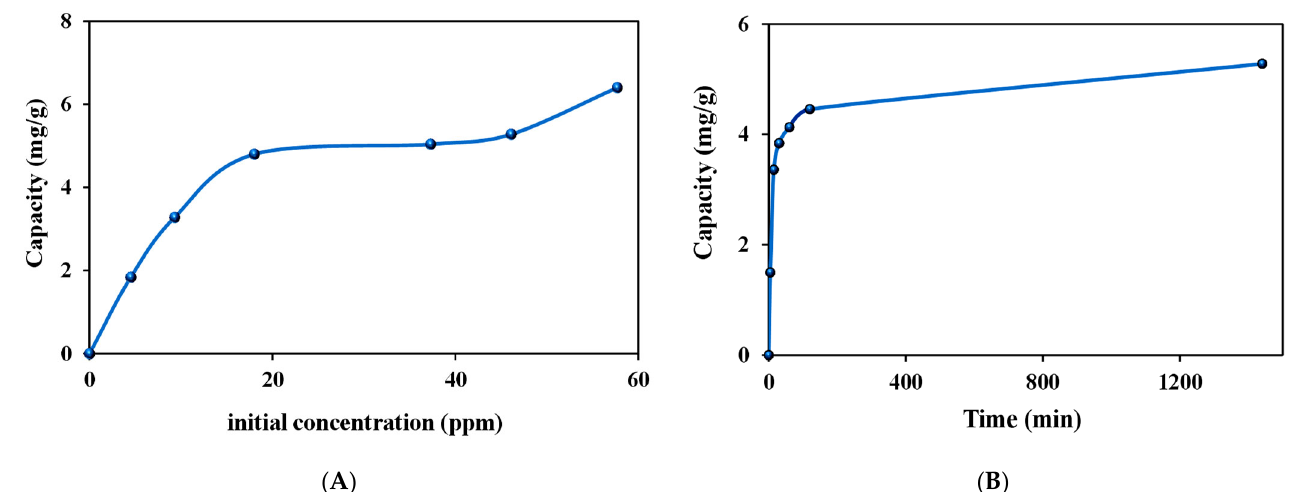
Figure 6. Au(III) capacities of ZrO 2 ‐ L 6 as a function of ( A ) initial concentration and ( B ) contact time. From Figure 6A, the Au(III) data reflected a continuous increase in capacity as the initial Au(III) concentration increased in the range of 0–20 ppm. This indicated that all the active sites on the zirconia surface were sufficient for the adsorption process at the studied Au(III) initial concentrations. The maximum experimental adsorption capacity was deter ‐ mined to be 6.4 mg/g for Au(III) using ZrO 2 ‐ L 6 nanoparticles.